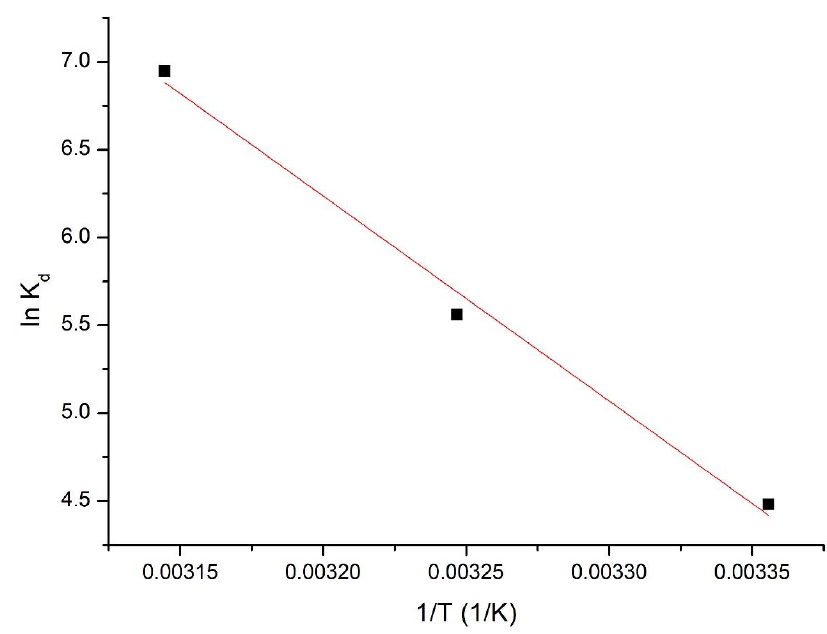
Figure 11. The ln Kd vs. 1/T plot.